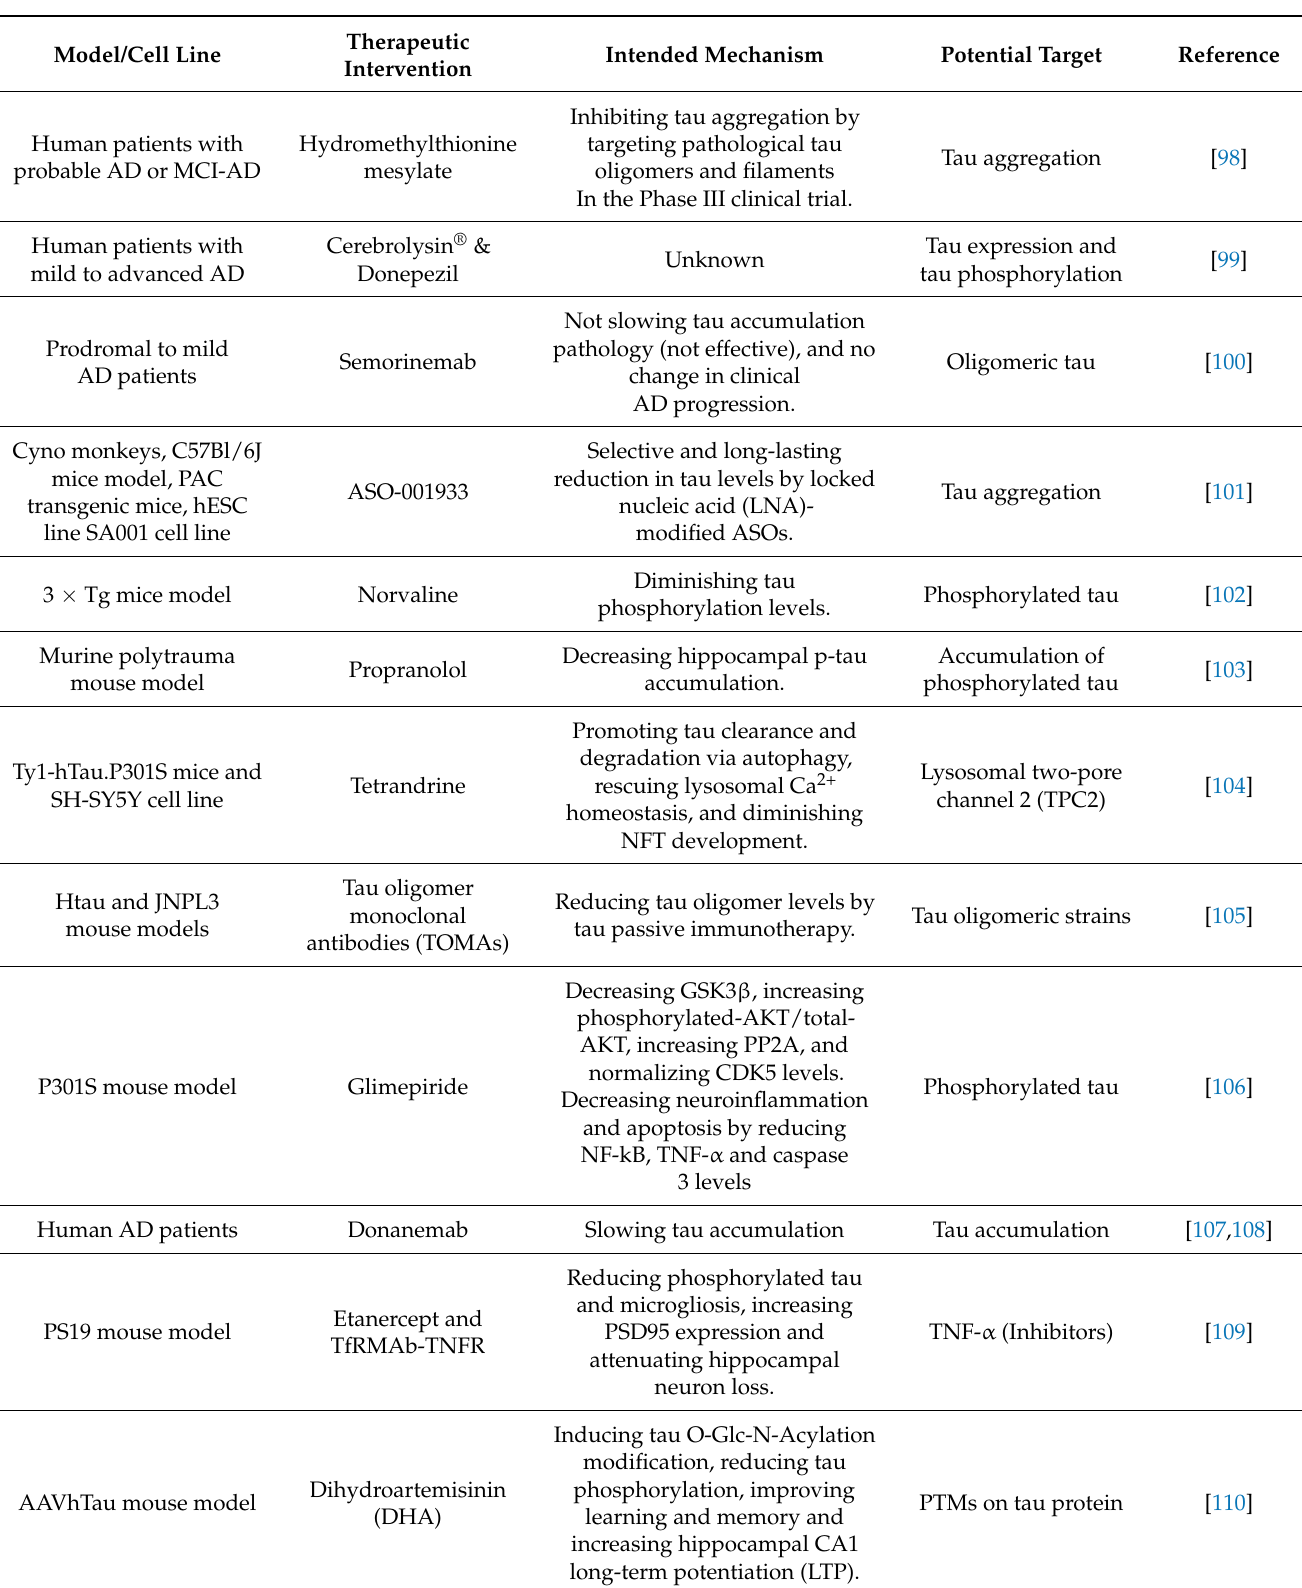
Table 1. Recent preclinical and clinical therapeutic interventions for